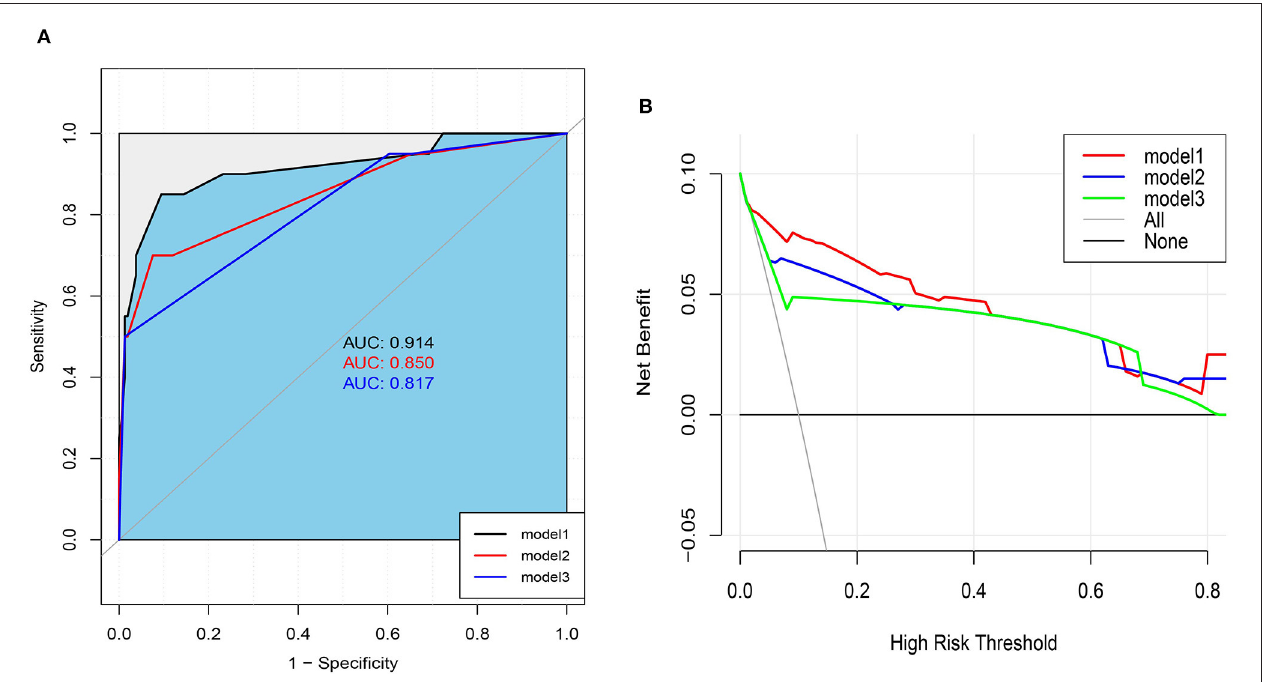
FIGURE 4 | (A) Area under ROC Curve of Three Models. (B) Decision Curve analysis for Nomogram and ESMO Guidelines (model 3) and model 2 in Predicting LNM Risk of T1 Colorectal